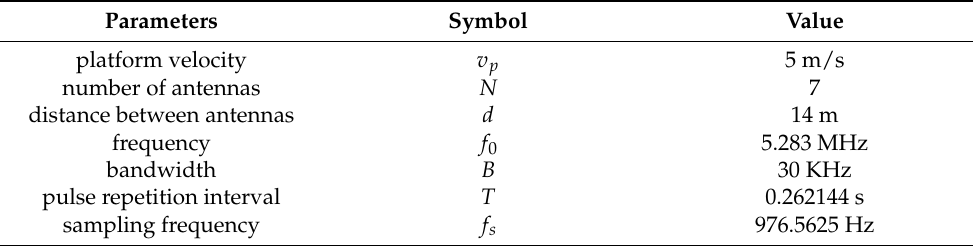
Table 1. System parameters [12].